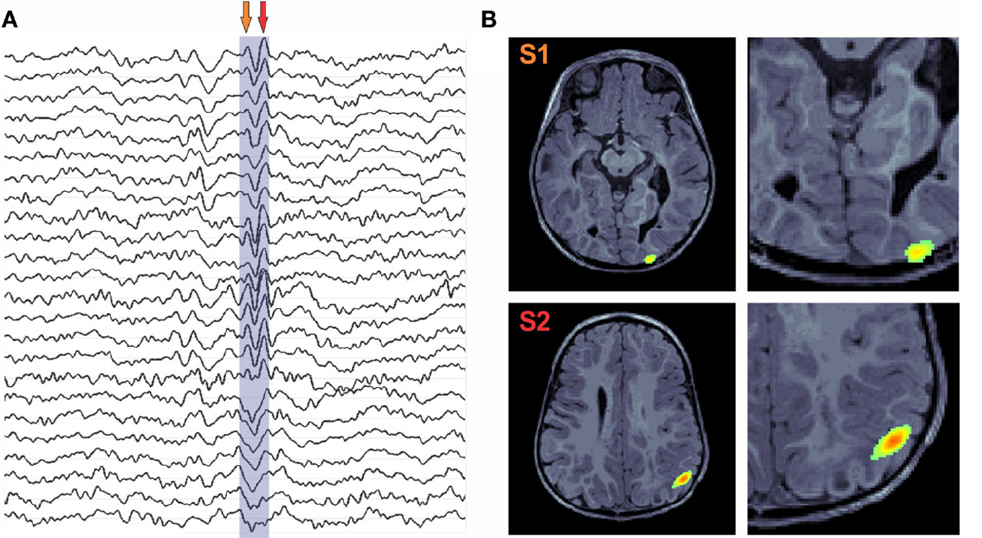
Figure 5. Shown here ( A ) are MEG traces of an epilepsy patient with spikes. In ( B ), Structural MRI with overlaid MEG activity. Reprinted from [72]. (Copyright 2014 Frontiers) Image reproduced as per terms of CC BY 3.0 license.